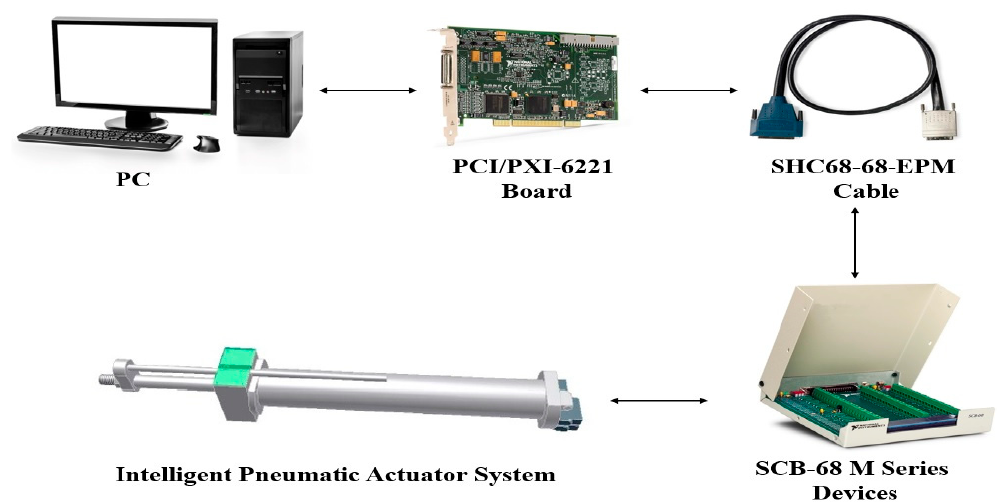
Figure 2. The experimental setup of the system. The experimental input and output data are utilized to create the mathematical model of the IPA system using the SI approach. A total of 1600 input and output data were collected from a real-time experiment with a sampling time of 0.01 s; 800 samples were used for training, and 800 samples were used for validation. The input and output data from the experiment are plotted in Figure 3.